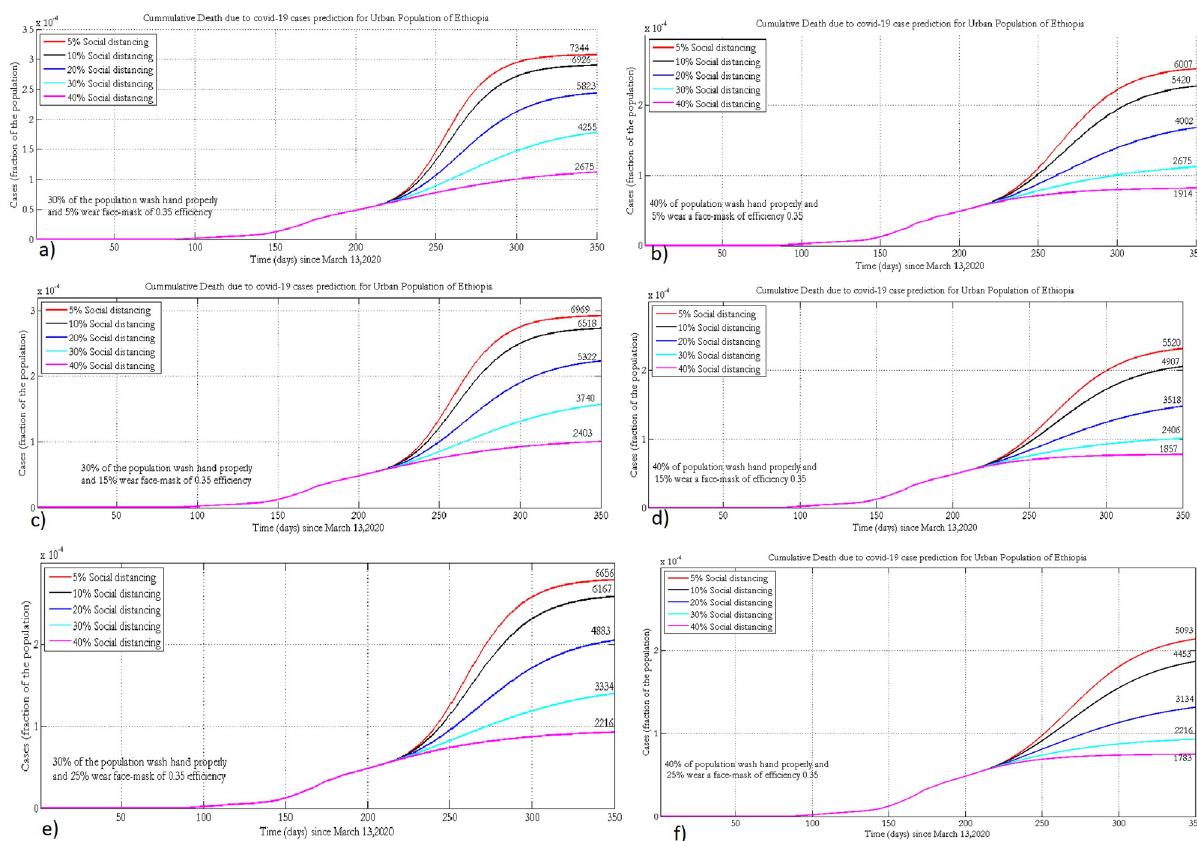
Fig 8. Projection of deaths under the implementation of different NPIs when 30% or 40% practice hand washing and 5% (a, b), 15% (c, d) or 25% (e, f) of the population wear face masks, with 35% efficacy.